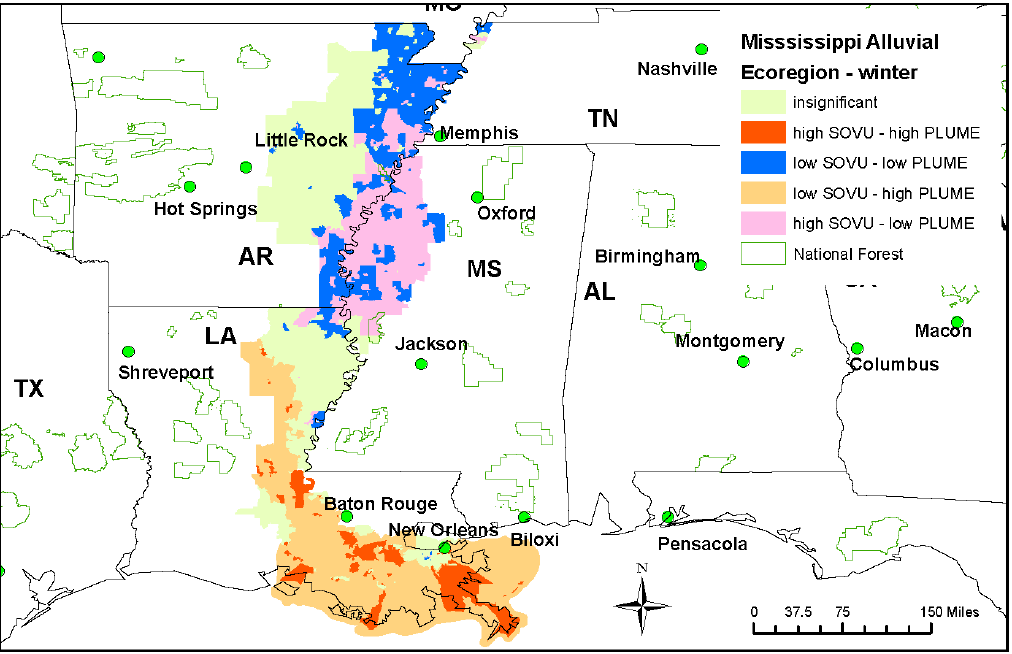
Figure 10. Bivariate LISA mapping of social vulnerability and smoke plume in the Mississippi-Alluvial ecoregion—winter.